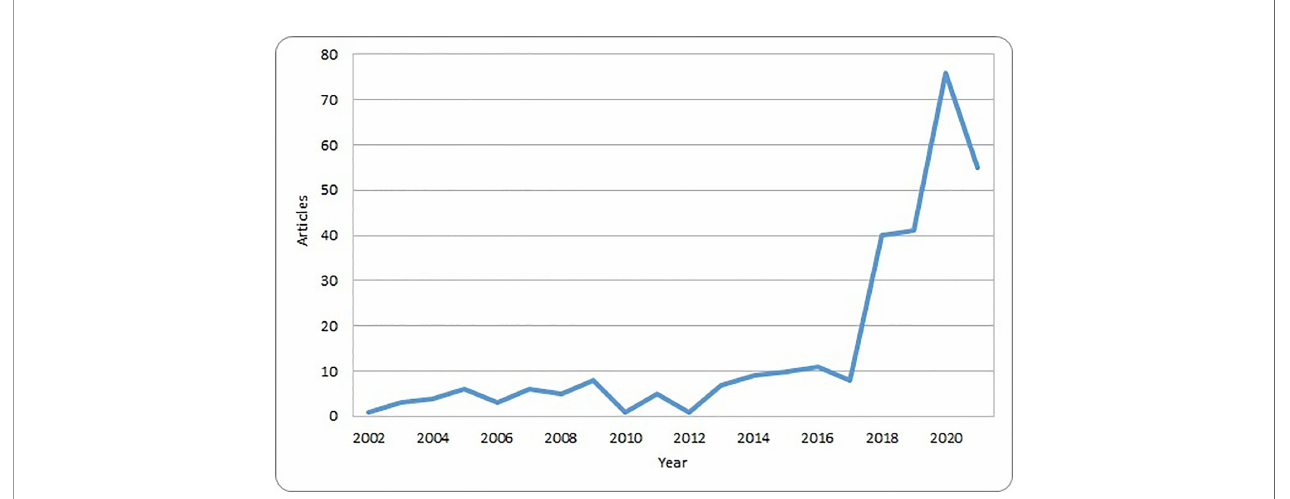
FIGURE 2 | Number of original papers included in the bibliometric analysis by year of publication.